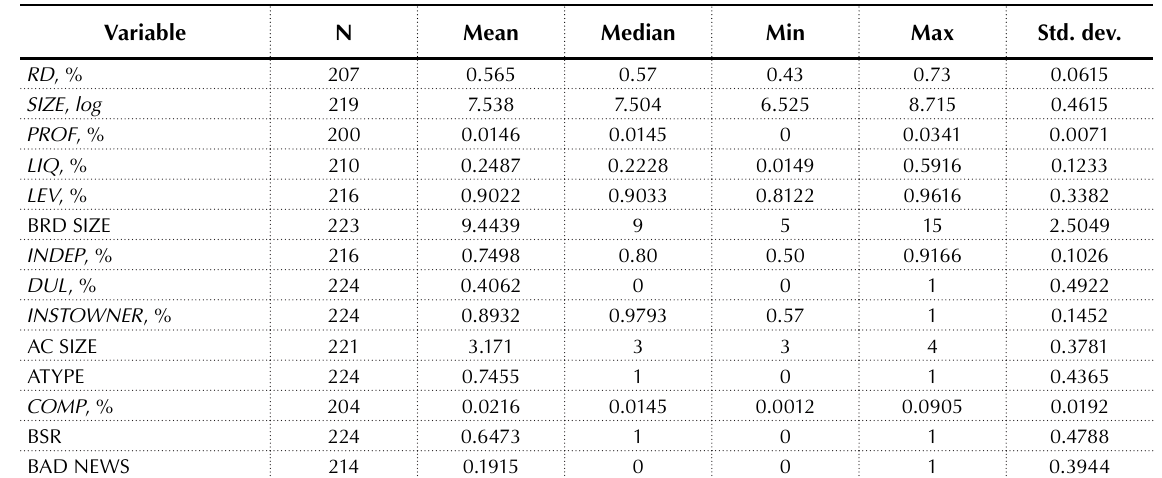
Table 3. Descriptive statistics